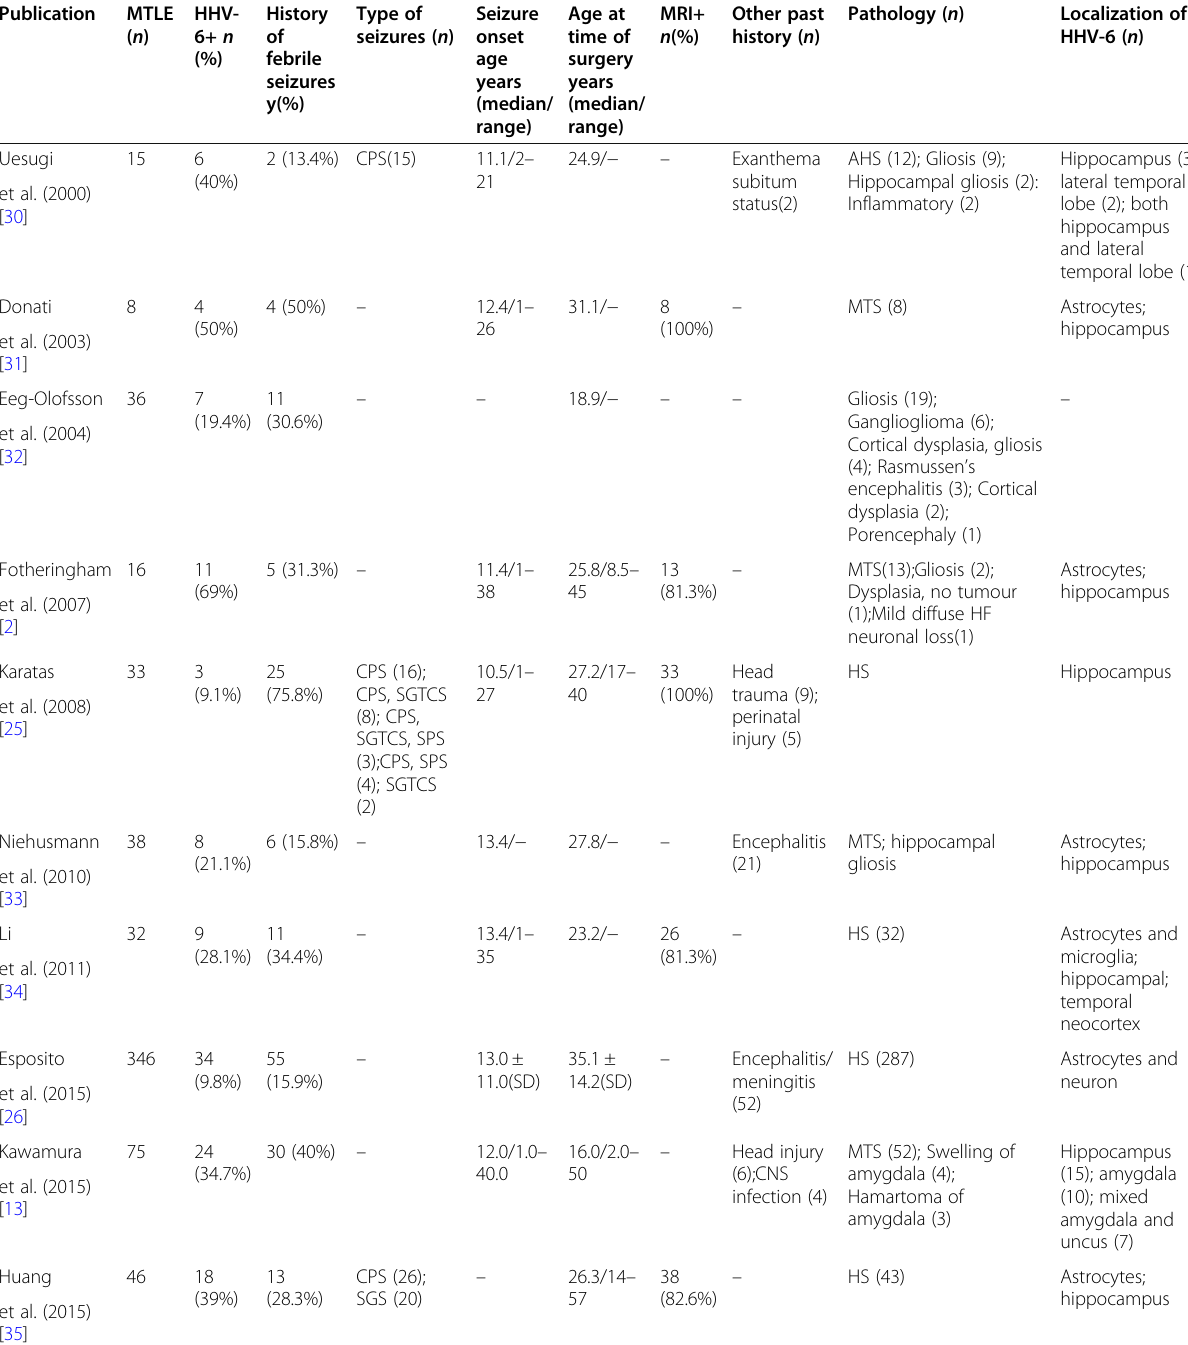
Table 1 Review of HHV-6 PCR-studies in patients with MTLE